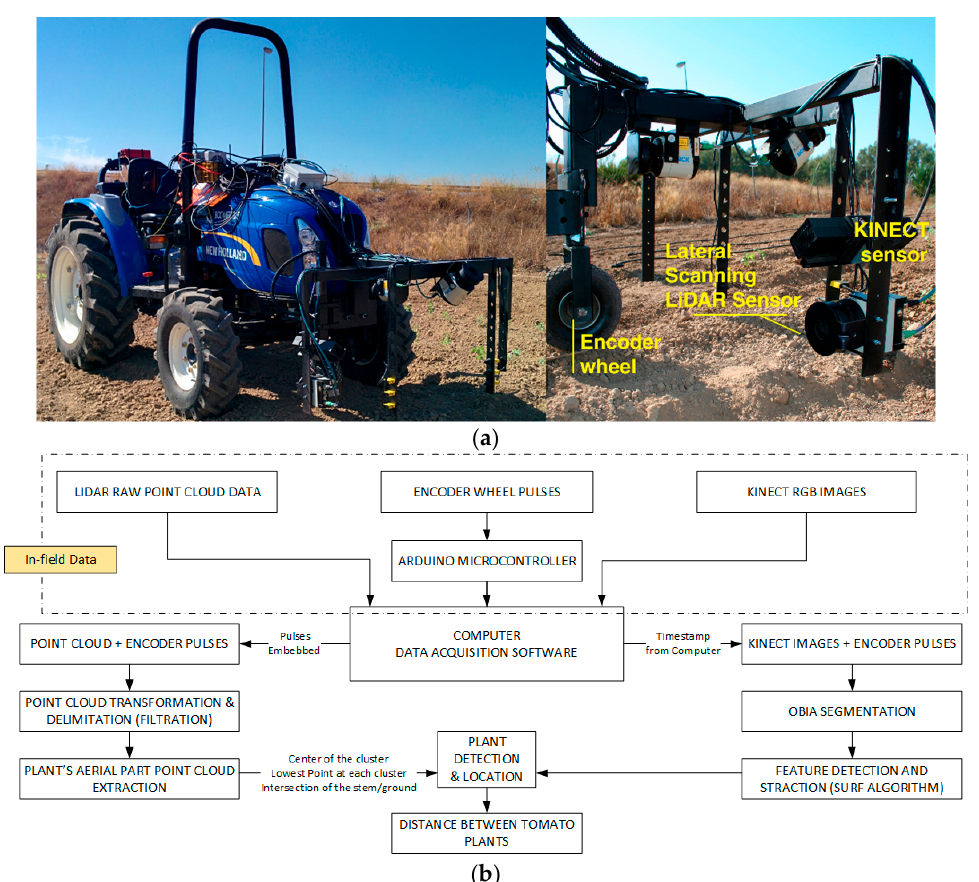
Figure 3. ( a ) Structure housing the sensors mounted on the tractor (left) and detail of the LiDAR and Kinect setup (right) for field trials at the University of Seville; ( b ) Progressive monitoring flowchart using LiDAR and Kinect sensors.